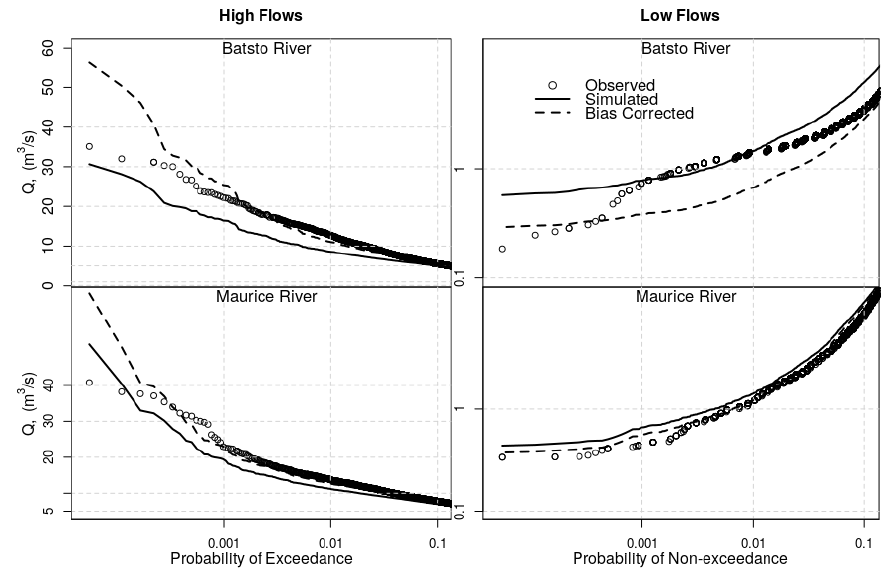
Figure 7. Tail of the full record flow duration curves for high and low flows (right and left plot in each row, respectively) in each river as